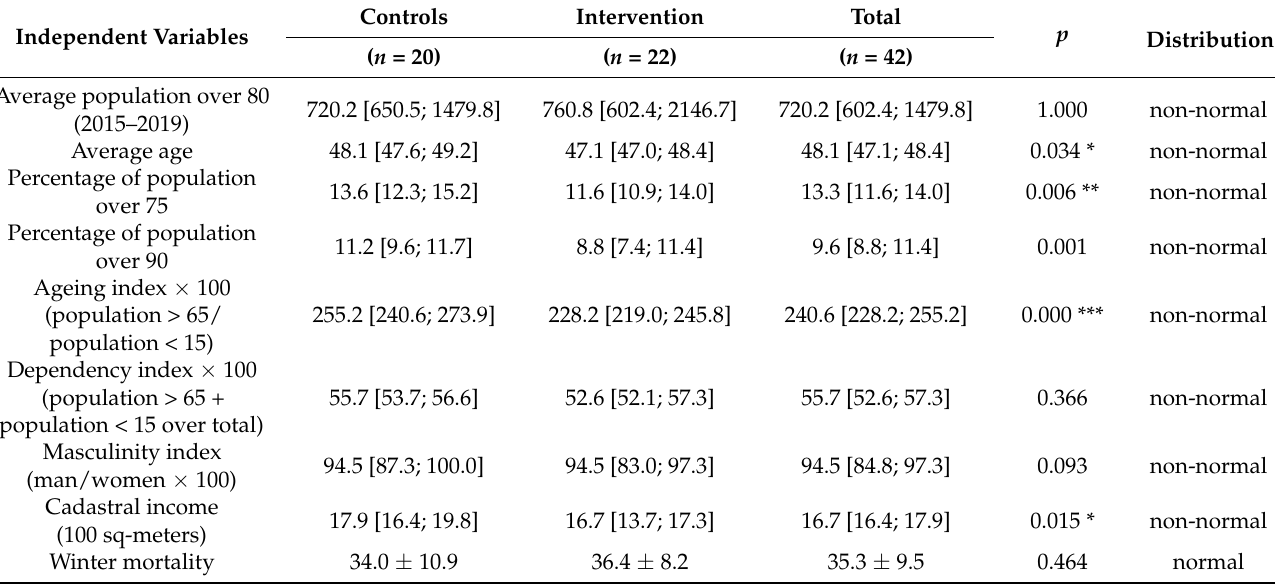
Table 1. Descriptive statistics of the urban